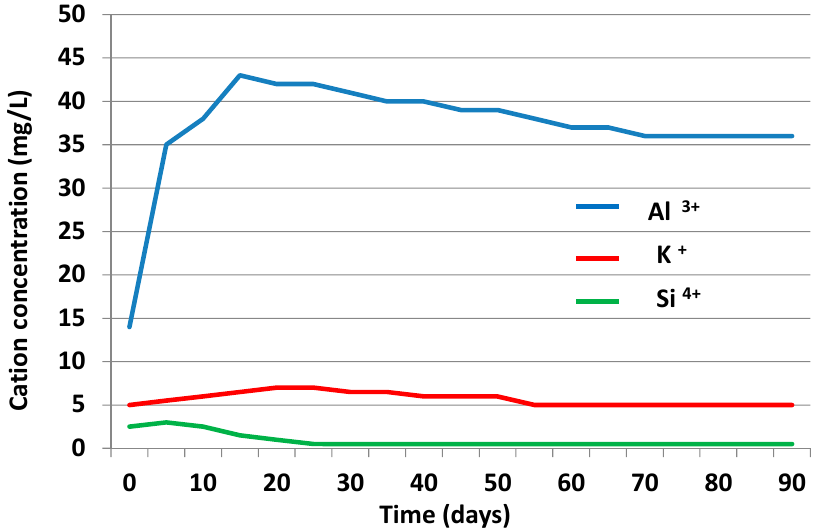
Figure 10. Behavior of ions during reaction in the kaolin activated at 750 °C/2 h. At 600 °C /2 h and 750 °C /2 h, the aqueous alumina increased in solution during the first 28 days and remained almost constant in the 1.3/1.5 mM range on longer time scales. The presence of 1% ZnO did not influence the behavior of the alumina in solution. The evolution of the aqueous alumina over time and the high concentration in solution suggest, in addition to a strong degradation of the primary minerals, the difficulty of the species of aqueous alumina (AlO 2 − in the alkaline medium) to be incorporated into the secondary minerals formed. Aqueous K + concentration increased over time, suggesting its replacement by Ca 2+ in the interlaminar region of the 2:1 phyllosilicates from natural kaolin and in the calcined materials. The K + concentration evolution in solution suggests that the process was favored by temperature and